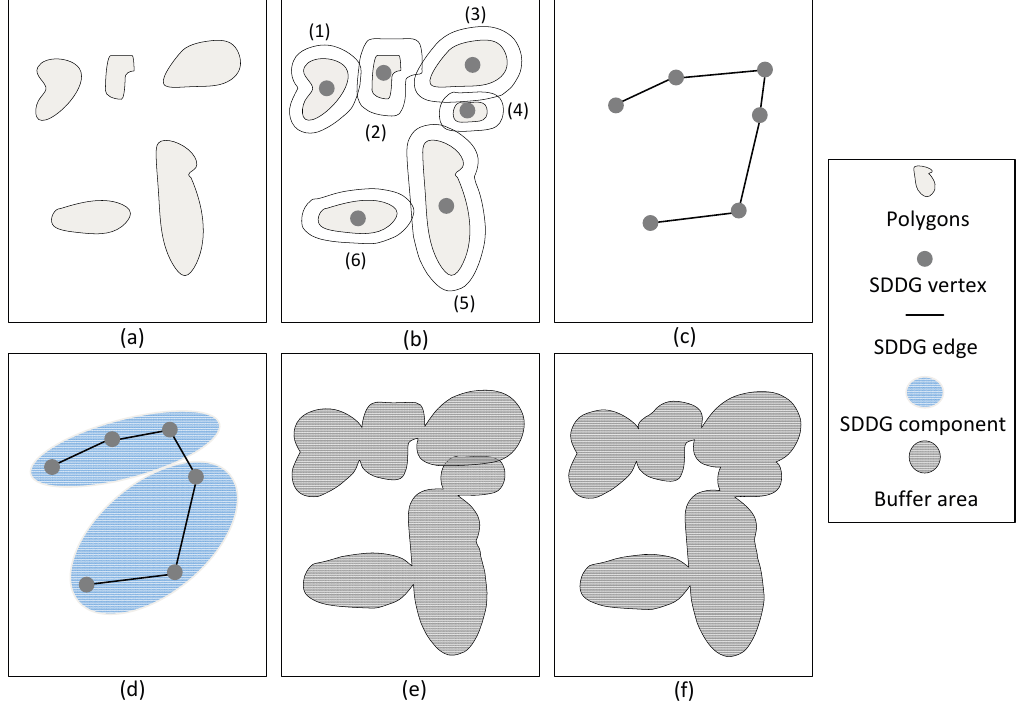
Figure 6. Parallelization of buffer operation. ( a ) Six polygons; ( b ) Initialization of SDDG; ( c ) The SDDG for buffer operation; ( d ) Partitioning of the SDDG; ( e ) Performing the two subtasks in parallel; ( f ) Merging the results of the